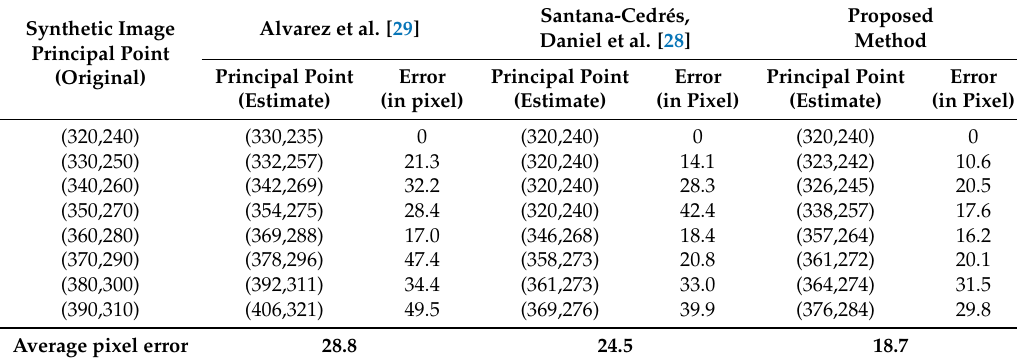
Table 5. Estimation Error of principal point (center of distortion) using various self-calibration techniques on synthetic